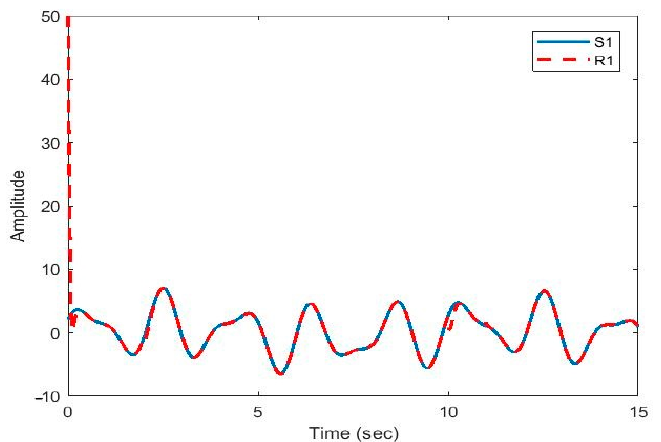
Figure 9. Plot of original signal ( S 1 ) and recovered signal ( R 1 ) obtained using multi-state synchronization and chaotic masking.